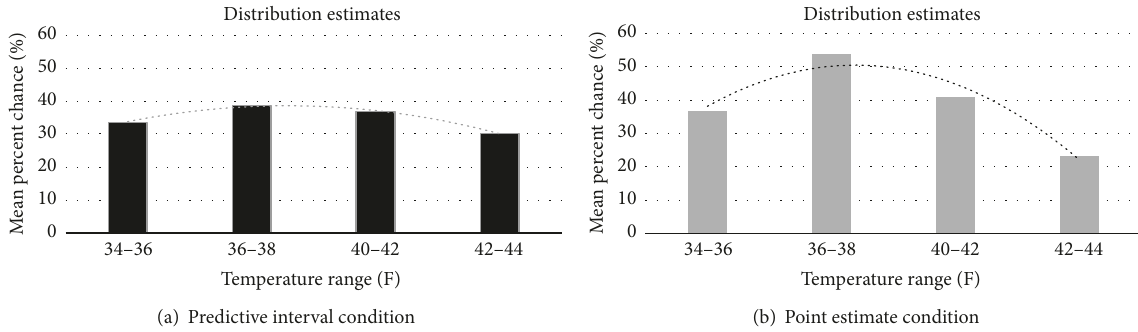
Figure 4: Mean percent chance estimates by participants for values within the predictive interval in Experiment 1.